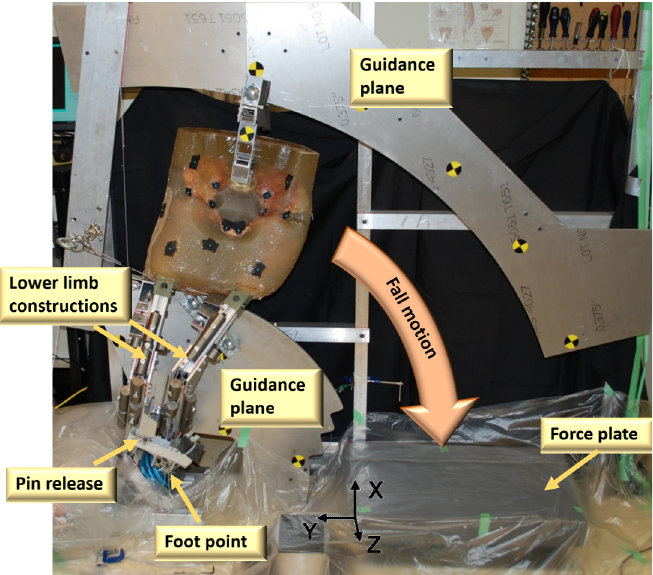
Fig 1. Experimental setup of the pendulum drop tests (reprinted from Fleps et al. [20]). Two planes were used to guide rollers attached to the lower limbs and pelvis. These guides constrained the specimen during the fall phase to a single degree of freedom. Cut guidance planes allowed for a free impact of the specimens, which were only constrained by the ball and socket joint at the foot point at impact. A pin-release constrained the motion of the contralateral leg during the fall phase but released it before impact. Rigid steel masses were added to the lower limb constructs to achieve subject specific target limb masses for each specimen. [22].